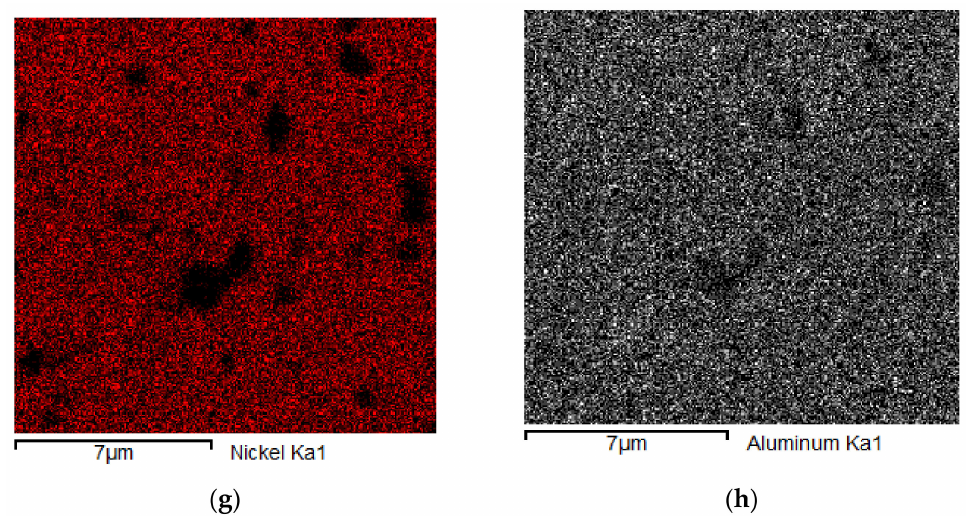
Figure 4. Maps of elements distribution in the composite’s structure, analysis parameters: Acc. Voltage: 15.0 kV; Resolution: 512 × 512 pixels; Viewed Resolution: 50%; Process Time: 5 s; Image Width: 14.7 µ m. ( a ) Mix; ( b ) Titanium; ( c ) Cobalt; ( d ) Molybdenum; ( e ) Chromium; ( f ) Niobium; ( g ) Nickel; ( h )